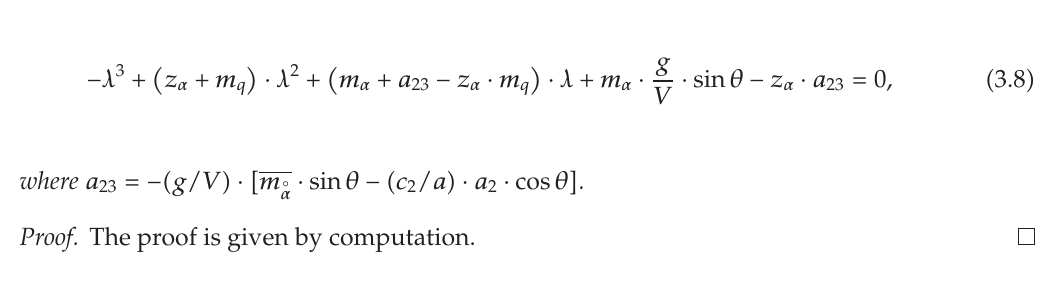
Figure 3: A transfer between two equilibriums, which belong to P 1 (cid:3) simulated in simplified model (cid:4) : δ (cid:6) − 0 . 03866 (cid:5) rad (cid:6) (cid:7) 2 . 216 ◦ → δ (cid:6)(cid:6) (cid:7) − 0 . 428832 (cid:5) rad (cid:6) (cid:7) 24 . 582 ◦ → α (cid:6)(cid:6) θ (cid:6) 1 − 40 . 016 ◦